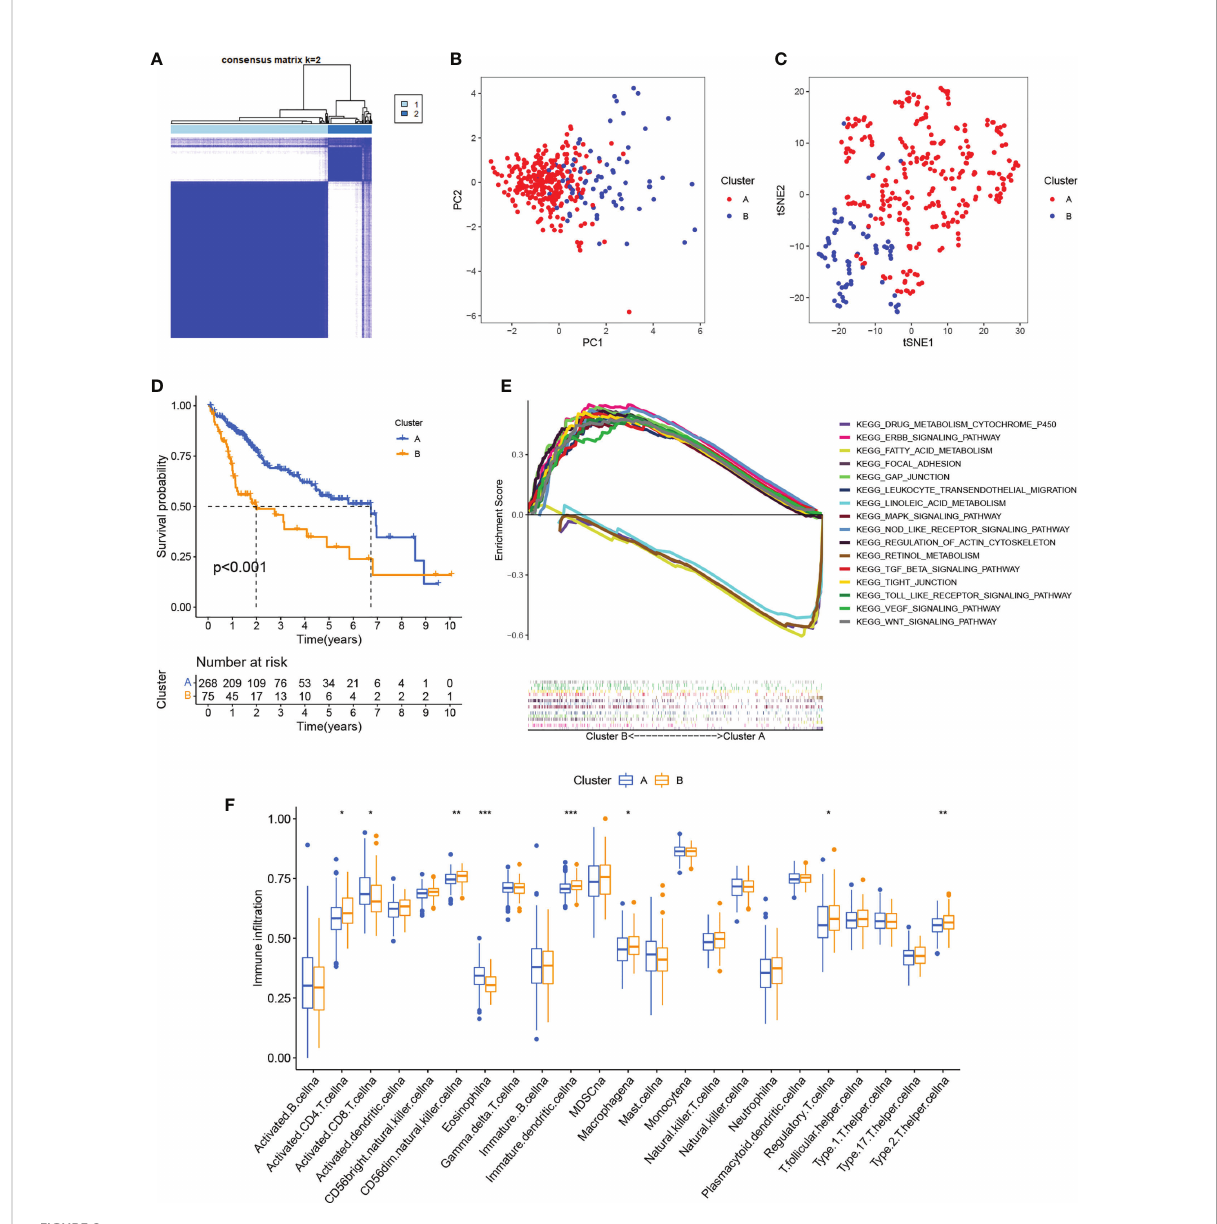
FIGURE 2 Identi fi cation of cuproptosis clusters. (A) Consensus matrix based on cuproptosis regulator expression in the HCC cohort at k = 2. (B) PCA of consensus matrix when k = 2. (C) T-SNE analysis of consensus matrix when k = 2. (D) K-M survival analysis between the two cuproptosis clusters. (E) Multiple GSEA analysis between the two cuproptosis clusters. (F) In fi ltration of immune cells between the two cuproptosis clusters. *P < 0.05; **P < 0.01; ***P < 0.001. HCC, hepatocellular carcinoma; PCA, principal component analysis; T-SNE, t-distributed random neighbor embedding; K-M, Kaplan-Meier; GSEA, gene set enrichment